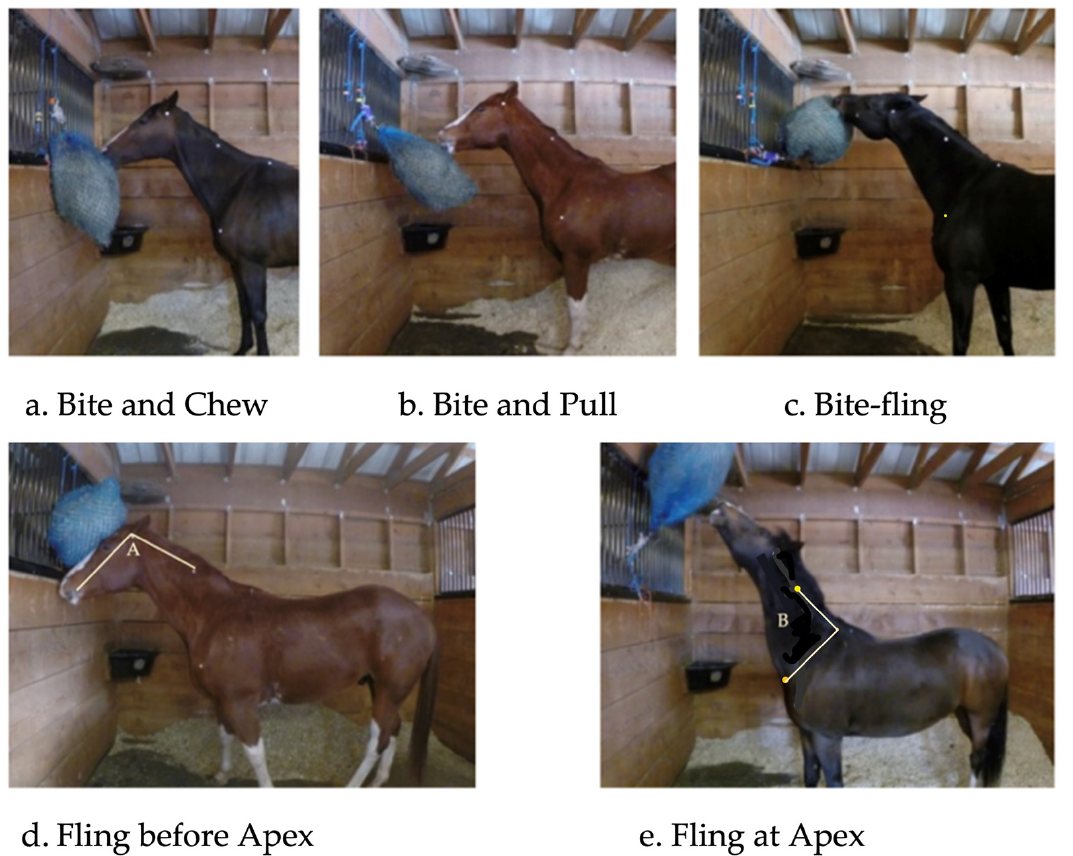
Figure 2. Eating ‘Haynet’ ethogram: ( a ) Eating: bites and chews not easily distinguishable; haynet stays more or less in place; ( b ) distinct bite on haynet and pull away from wall with teeth; ( c ) bite- fling: bite with lifting upwards of haynet; ( d ) fling: push haynet upwards fast with head before taking a bite; ( e ) fling: fling and ‘throw’ of haynet with bite/teeth and head; (Lines: illustration of angles measured A-poll angle, B-wither angle) (Images: